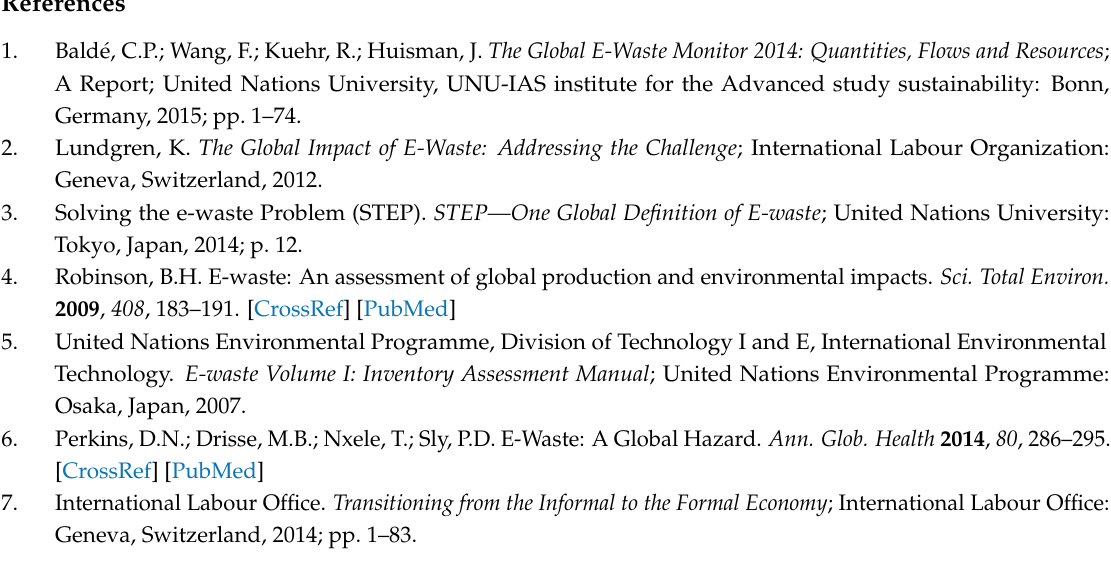
Table S1: Socio-demographic characteristics of all the informal workers, Table S2: Knowledge of work health risk, Table S3: Healthy work Attitude at work, Table S4: Healthy work